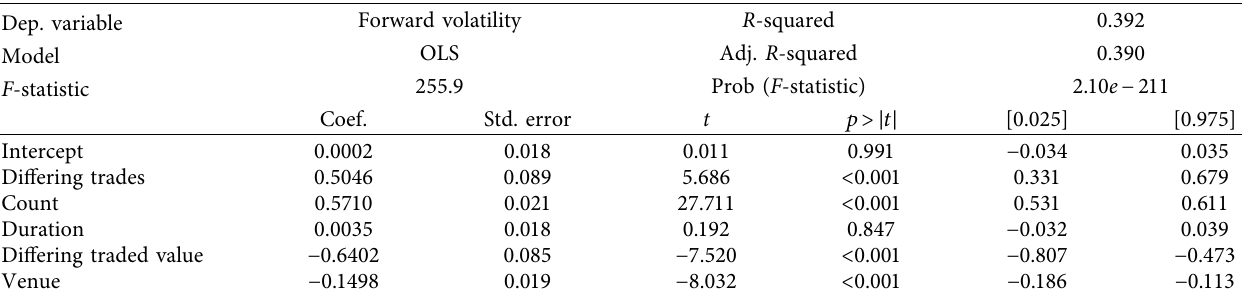
Table 3: Linear regression diagnostics for forward volatility as a function of trade statistics, dislocation statistics, and venue fluctuation. Dep.